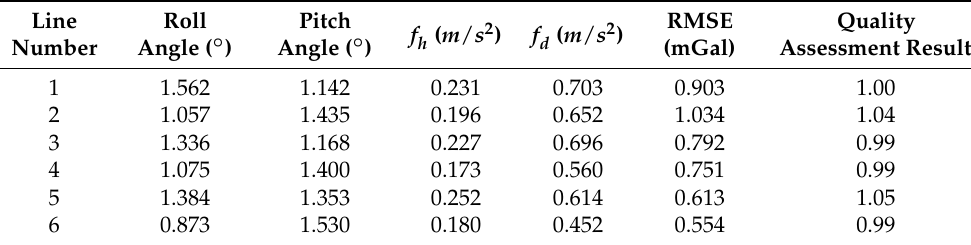
data in strapdown gravimeter and the quality of gravimetry. Compared with internal RMSE, quality assessment model was conservative and strict in these two surveys. The quality assessment results in different surveys indicated that quality assessment model could be used to estimate the performance of strapdown airborne gravimeter and could be regarded as an important reference index for surveyors to control the gravimetry process as well. As a case, the shown method also could be applied to other strapdown Table 7. The standard deviation of four factors and internal RMSE in Neimeng flight.